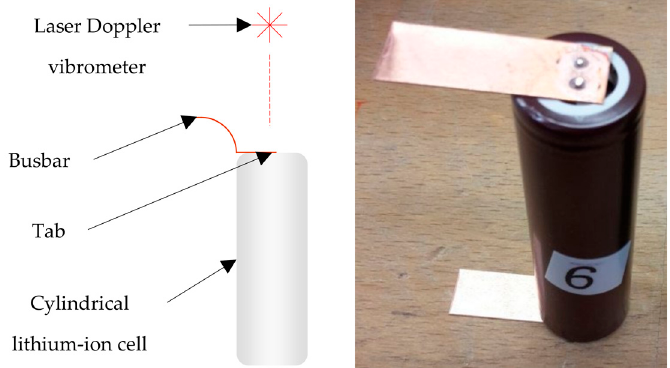
Figure 1. Cylindrical cell with attached tabs.